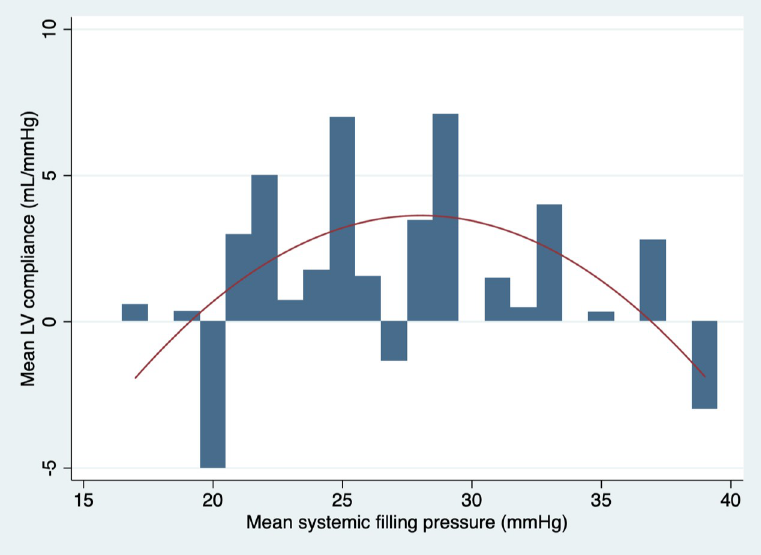
The relationship between left ventricular compliance and mean systemic filling pressure with sheep 3 and 4 excluded from the analysis is presented in Fig 4. The best equation to